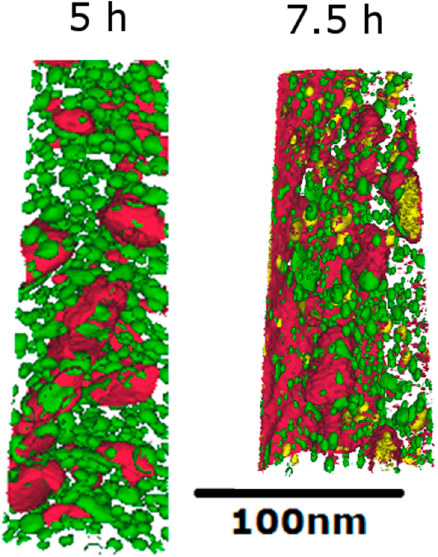
Figure 2. Isosurfaces from APT (Atom probe tomography) of the alloys, of Ni in green to represent NiAl, Mo in red and Cr in yellow to represent Laves phase. The image on the left is after ageing for 5 h and on the right after ageing for 7.5 h; both are after austenitisation at 960 °C.